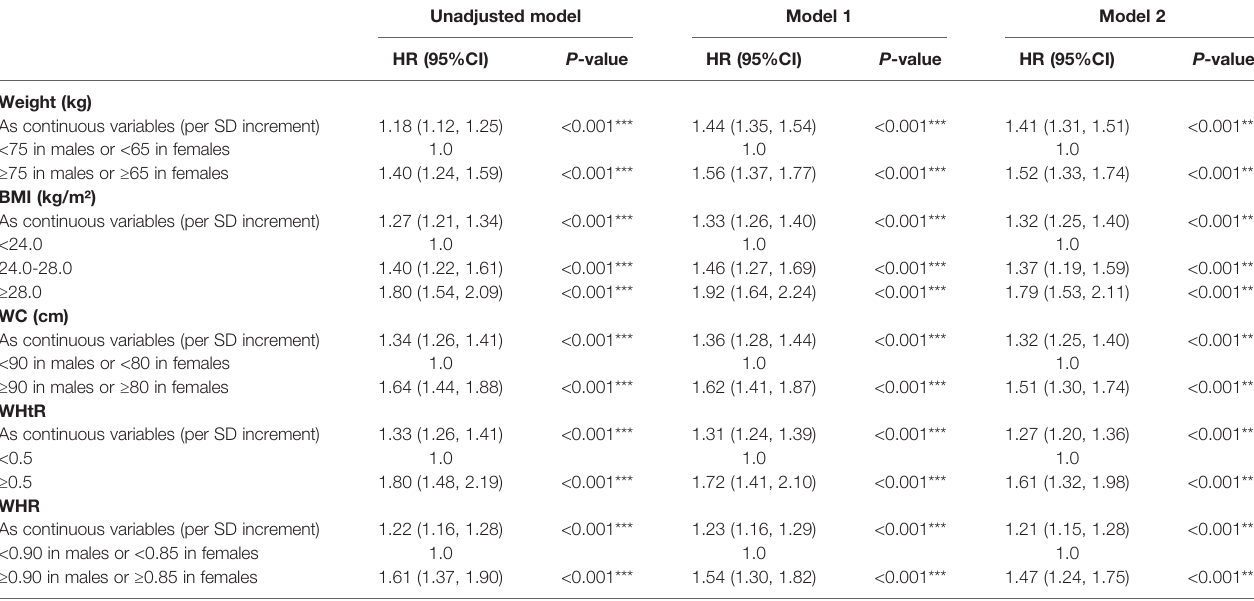
TABLE 2 | Multivariate cox regression models evaluating the associations of baseline established anthropometric indices with the development of